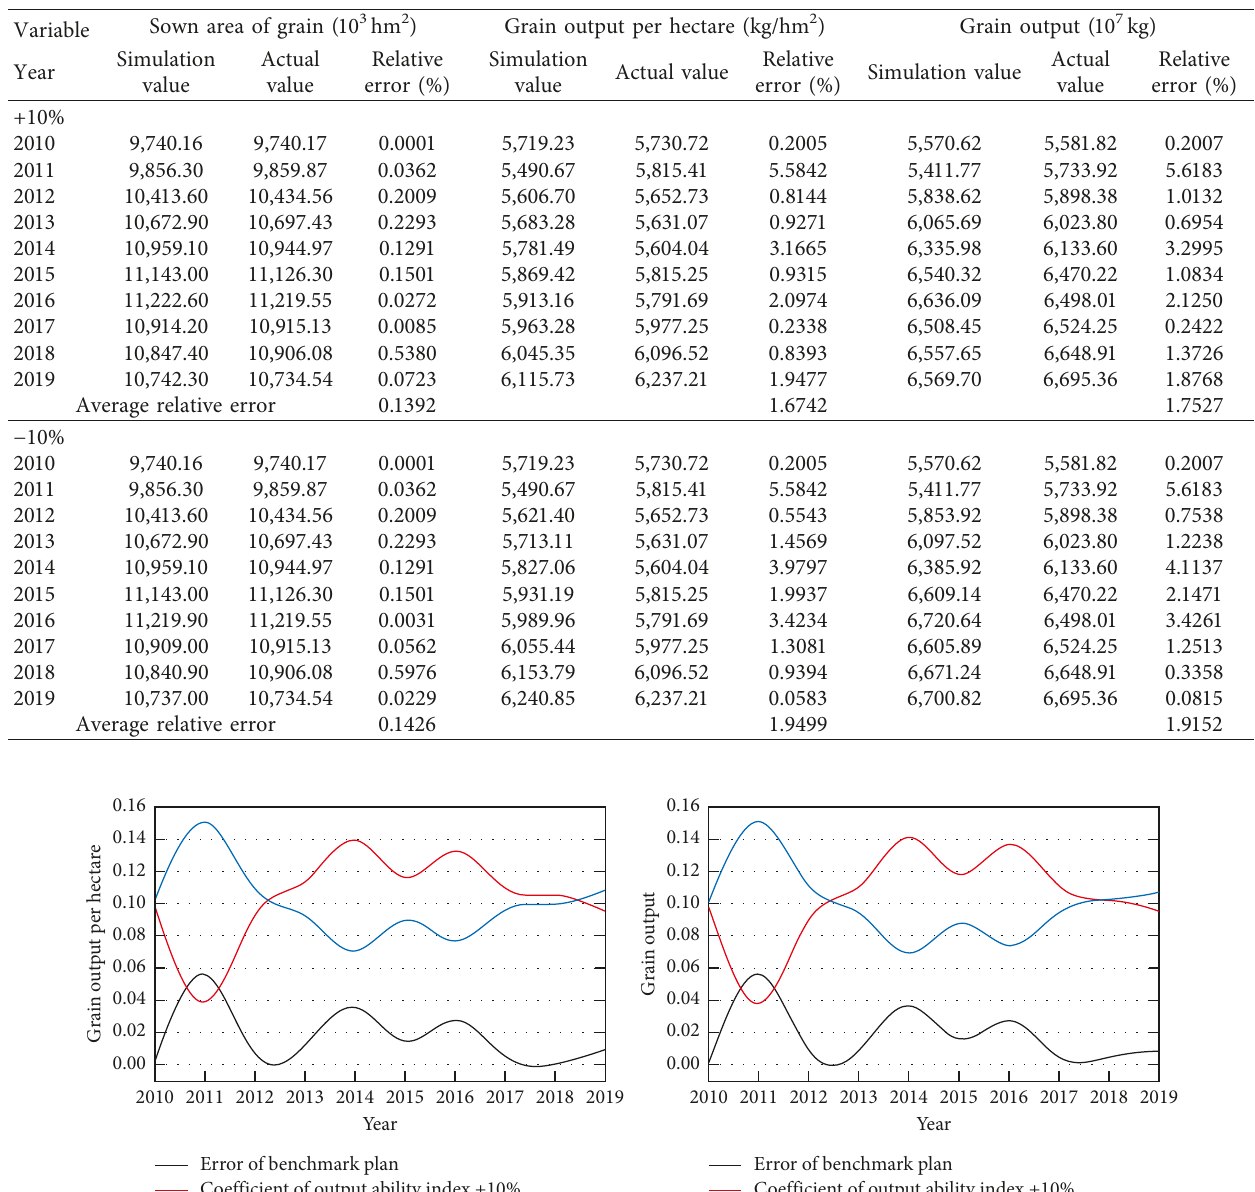
Table 5: Comparison of coefficient test results.